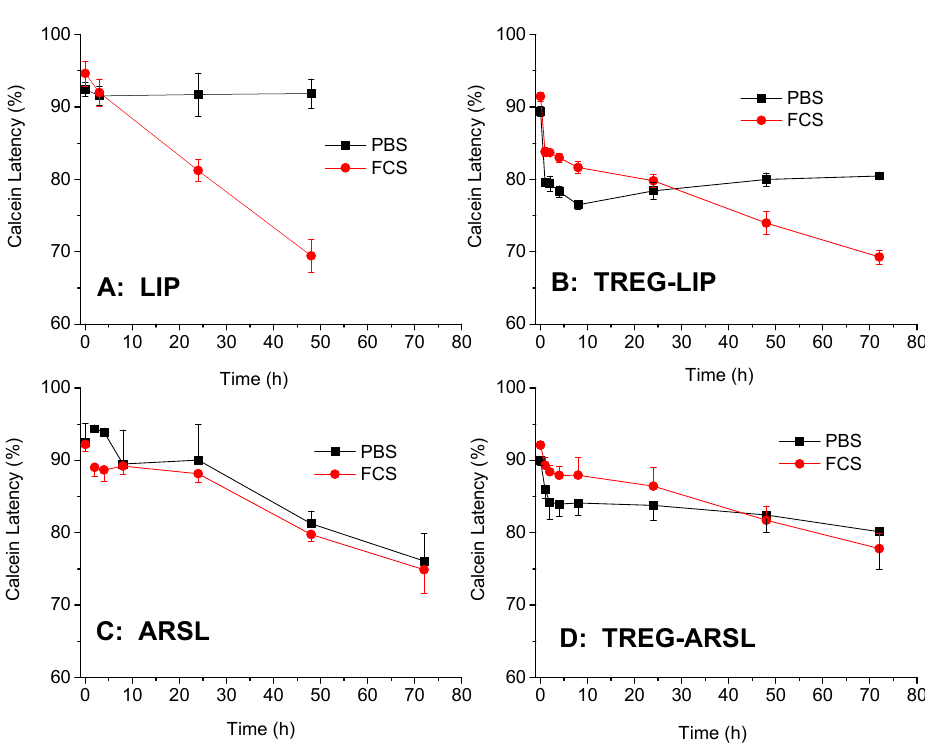
Figure 3. Calcein Latency (%) of vesicles during incubation in PBS and FCS at 37 °C. ( A ) Liposomes; ( B ) TREG ‐ LIP; ( C ) ARSL; ( D ) TREG ‐ ARSL.